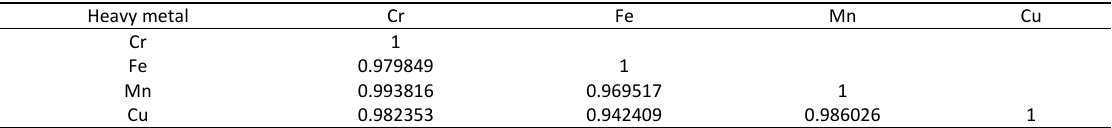
Table. 2 : Correlation matrix of heavy metals Table 2: Correlation matrix of heavy metals Heavy metal Cr Fe Cr 1 Fe